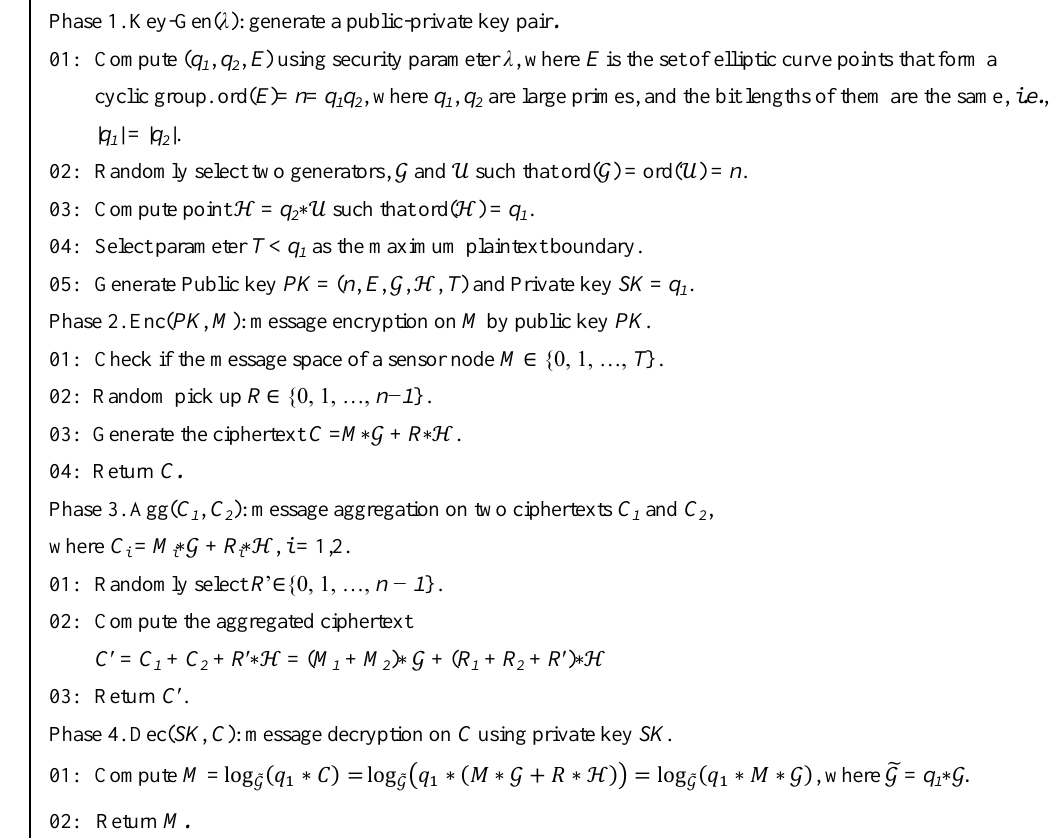
Algorithm 1. BGN